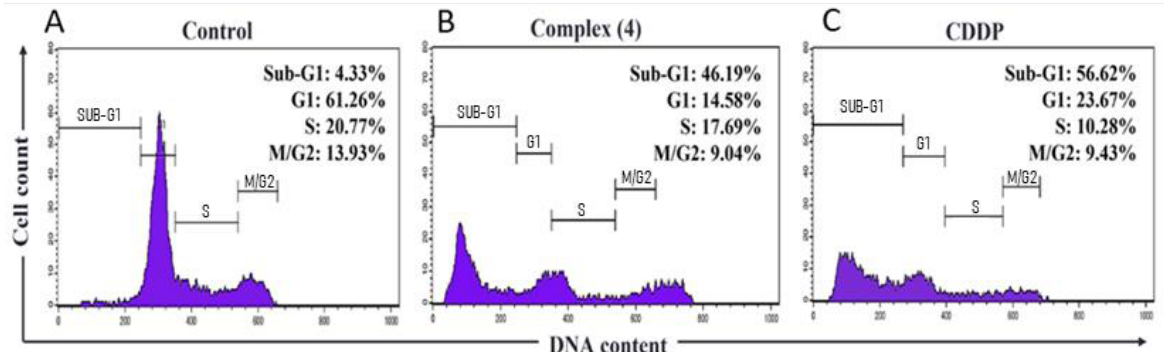
Table 1. Cell cytotoxicity induced by the platinum complexes determined by MTT assay.